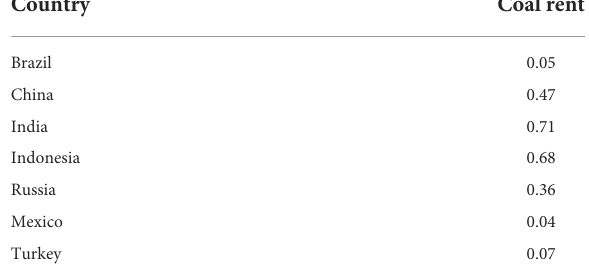
TABLE 3 Coal rent of E7